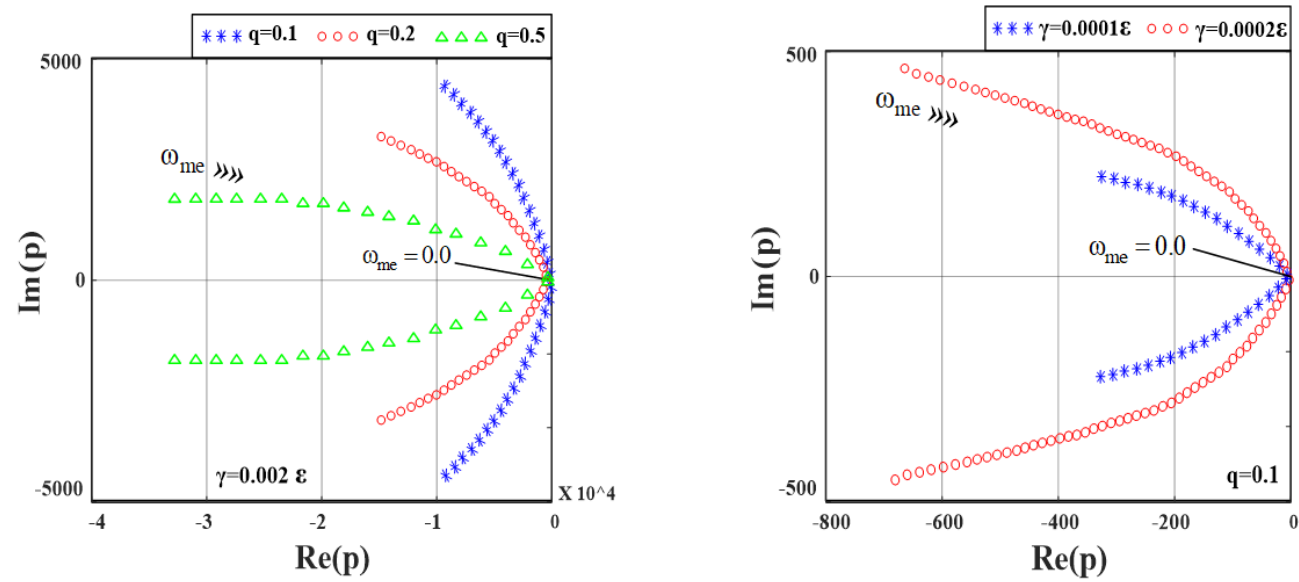
Figure 4. Eignenvalues of rotor flux estimation error’s system.